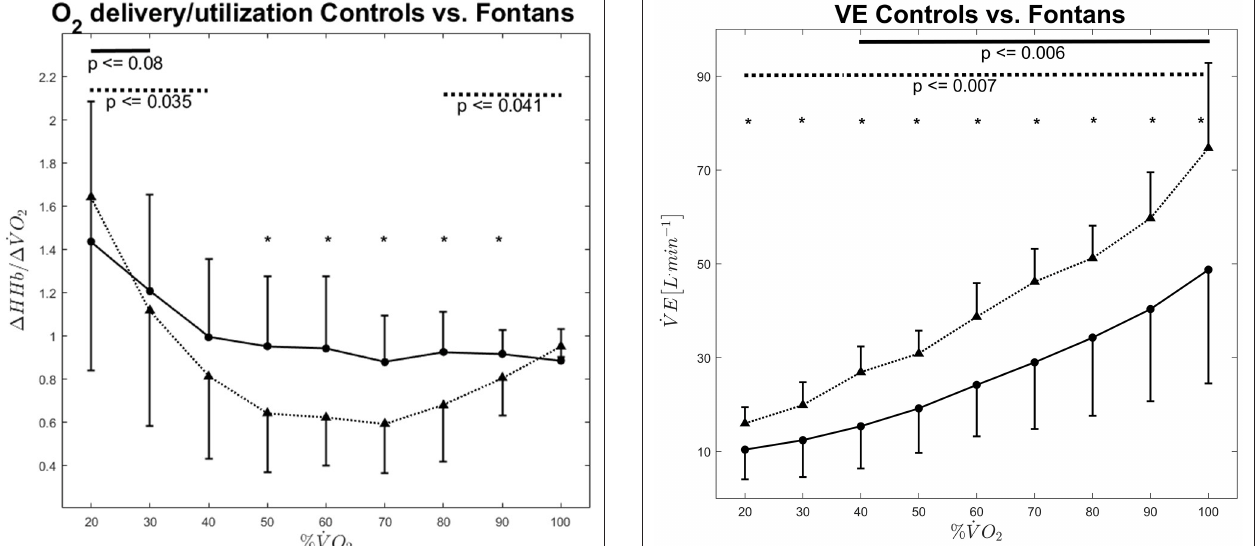
FIGURE 3 | 1 HHb/ 1 VO 2 ratio vs. exercise intensity for Fontans (solid line) and Controls (dashed line). The solid and dashed lines in the upper section indicate significant differences between intensities among Fontans and Controls, respectively. Significant differences ( p < 0.05) between Fontans and Controls within one exercise intensity are marked with asterisks.